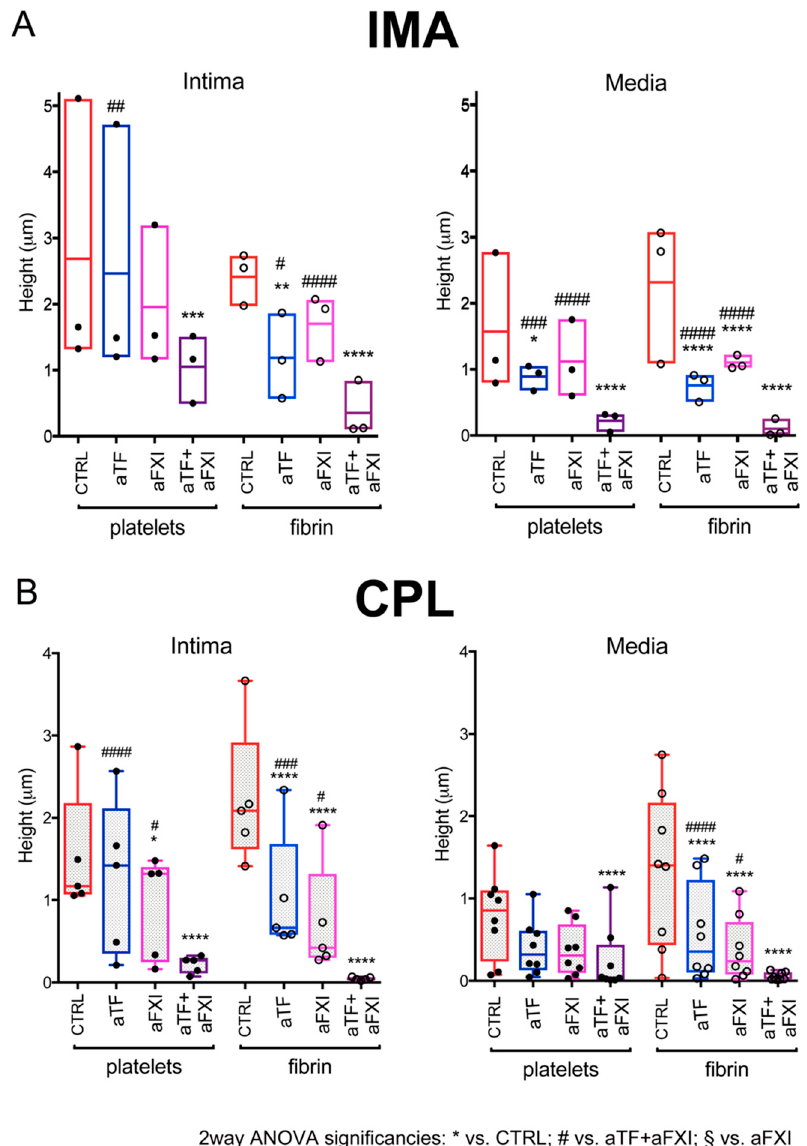
Figure 2. Influence of coagulation pathway blockades on thrombus formation over vascular tissue. Quantification by confocal sectioning of platelet aggregated and fibrin deposited over 3 IMA ( A ) and 8 CPL ( B ) sections upon perfusion of normal human blood. Not all the layers were available for sampling in all the CPL. Circulating TF and/or coagulation FXI were neutralized by adding specific monoclonal antibodies to blood (aTF, aFXI). Data are presented as boxes (5–95 percentile), and dots indicate the mean value from ≥ 4 to 5 fields/sample; thrombus height (volume/ROI) is presented. Symbols indicate significant differences: * vs. CTRL, # vs. aTF + aFXI by 2way ANOVA with Tukey’s multiple comparisons test for paired comparisons. *, # p < 0.05 and **, ## p < 0.01, ***, ### p < 0.001, ****, #### p < 0.0001.